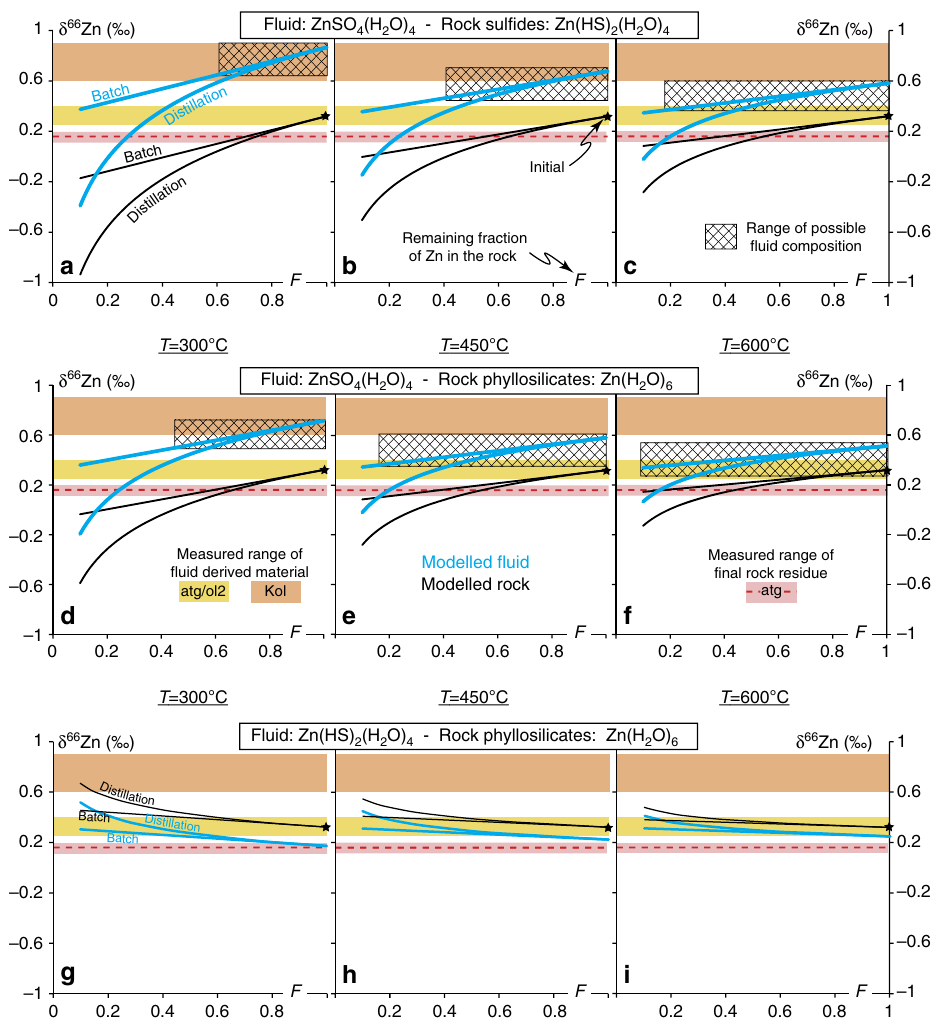
Figure 2 | Modelling of d 66 Zn evolution in slab fluids and residual serpentinites for the sulfate- and sulfide-bearing fluid scenarios. Evolution of residual serpentinite d 66 Zn (in black) and that of associated fluids (in light blue) with the remaining fraction of Zn in the rock (F) using batch and Rayleigh distillation models. The models were performed at 300 (cid:2) C ( a , d , g ), 450 (cid:2) C ( b , e , h ) and 600 (cid:2) C ( c , f , i ). The models were performed using fractionation at equilibrium fractionation factors, a , b , c : between Zn contained in the serpentinite sulfides (ZnHS 2 (H 2 O) 4 ) and a sulfate-rich fluid (ZnSO 4 (H 2 O) 4 ). d , e , f : between Zn contained in the serpentinite phyllosilicates (Zn(H 2 O) 6 ) and a sulfate-rich fluid (ZnSO 4 (H 2 O) 4 ) and g , h , i : between Zn contained in the serpentinite phyllosilicates (Zn(H 2 O) 6 ) and a sulfide-rich fluid (ZnHS 2 (H 2 O) 4 ). The fate of Zn in the rock sulfides is not reported as there is no fractionation at equilibrium with only one species in solution (ZnHS 2 (H 2 O) 4 ). The solid coloured areas represent the range of d 66 Zn in measured samples for antigorite Alpine serpentinites (in red), and fluid-derived material (in yellow: atg/ol2-serpentinites and in orange: Kohistan olivines Kol). The grid represents the range of possible fluid compositions from the initial starting composition (black star) to the end of the antigorite field, defined by the observed range of d 66 Zn in the samples (in red). Fractionation factors from Black et al. and Fujii et al. 2,14 . The model is fully described in the